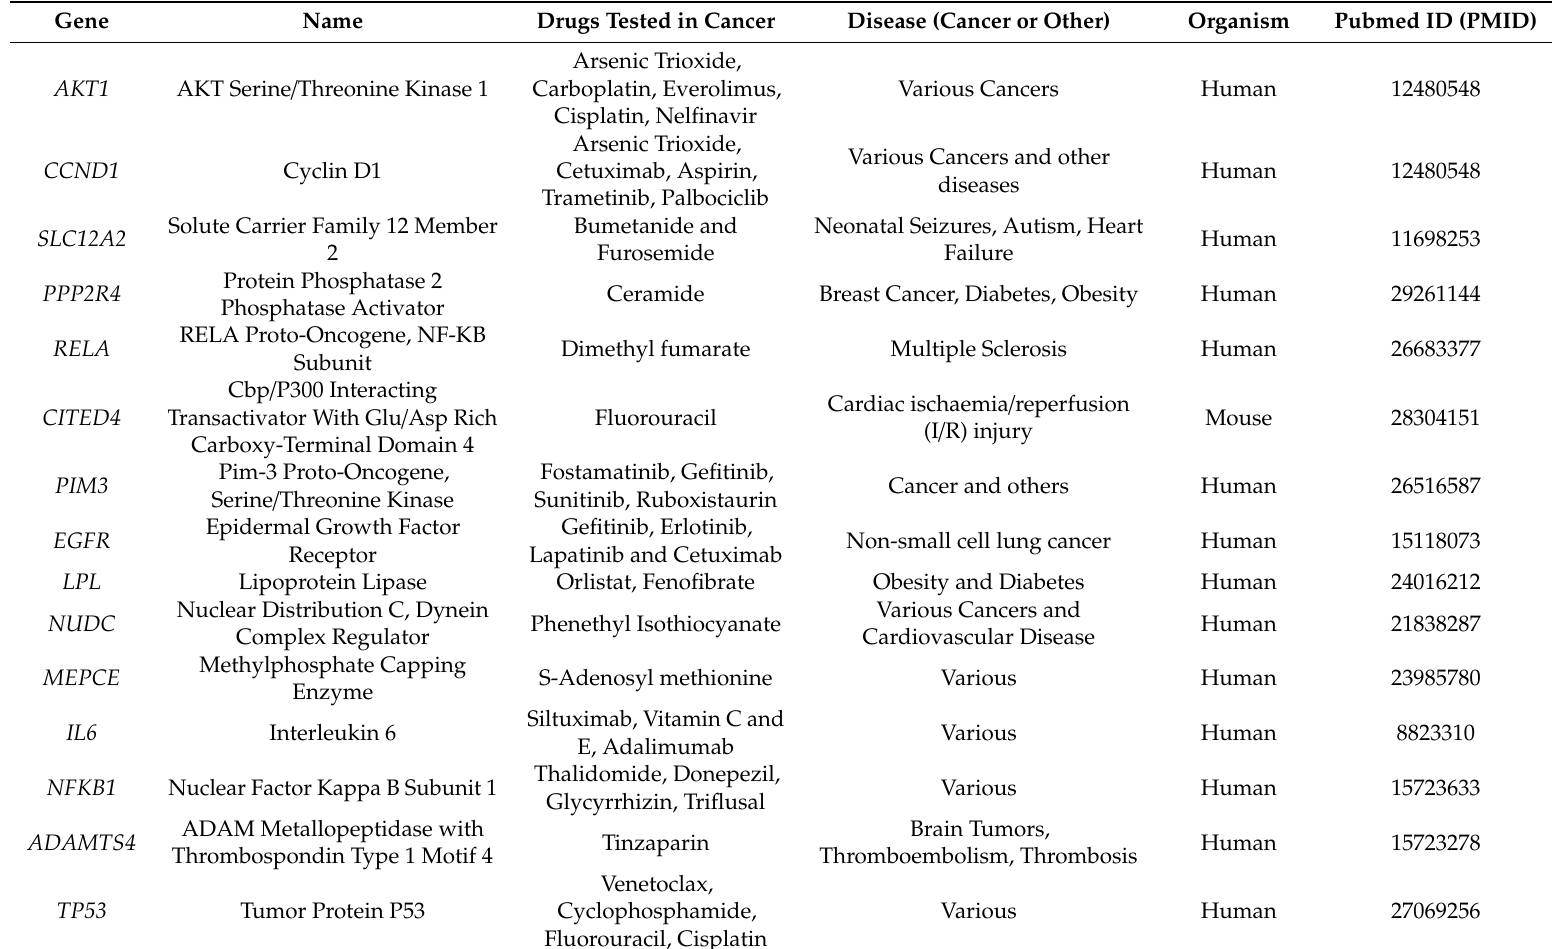
Table 1. Genes involved in networks with African ancestry-associated genes are potential therapeutic / disease management targets with currently utilized